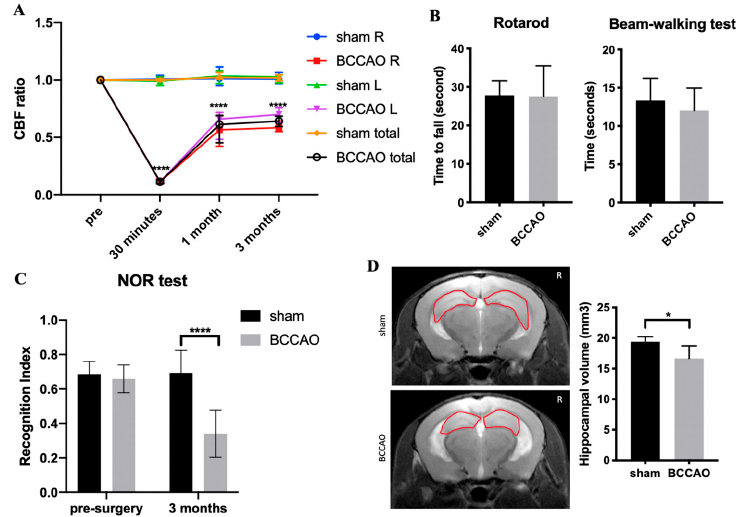
Figure 1. Effect of chronic cerebral hypoperfusion (CCH) on mice at 3 months after the bilateral common carotid artery occlusion (BCCAO) and sham surgery. ( A ) Cerebral blood flow (CBF) reduced to 50–70% from the baseline in BCCAO mice; ( B ) CCH did not alter motor coordination, which was observed as no difference in the rotarod and beam-walking test; ( C ) Novel object recognition (NOR) test showed that BCCAO mice had memory decline compared with sham mice after CCH induction; ( D ) CCH induced hippocampal atrophy in BCCAO mice (the area of hippocampus is shown by a red circle). n = 6 for each group. Data are presented as the mean + standard deviation; * p < 0.05 by unpaired t-test (hippocampal volume); **** p < 0.0001 by two-way analysis of variance followed by Sidak’s multiple comparison test (CBF ratio and NOR). Sham R: right brain area of sham mice, sham L: left brain area of sham mice, BCCAO R: right brain area of BCCAO mice, BCCAO L: left brain area of BCCAO